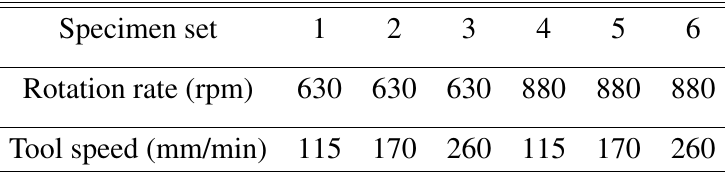
Table 1 . Parameters used for the FSP (data source: [99]).